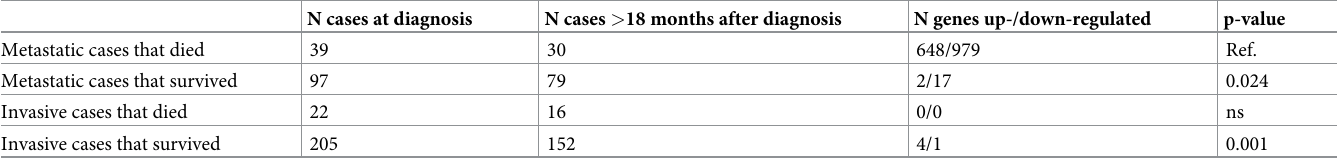
Table 2. Comparison of the number of differentially expressed genes between the four strata of breast cancer cases, using using metastatic breast cancer patients that died as reference.